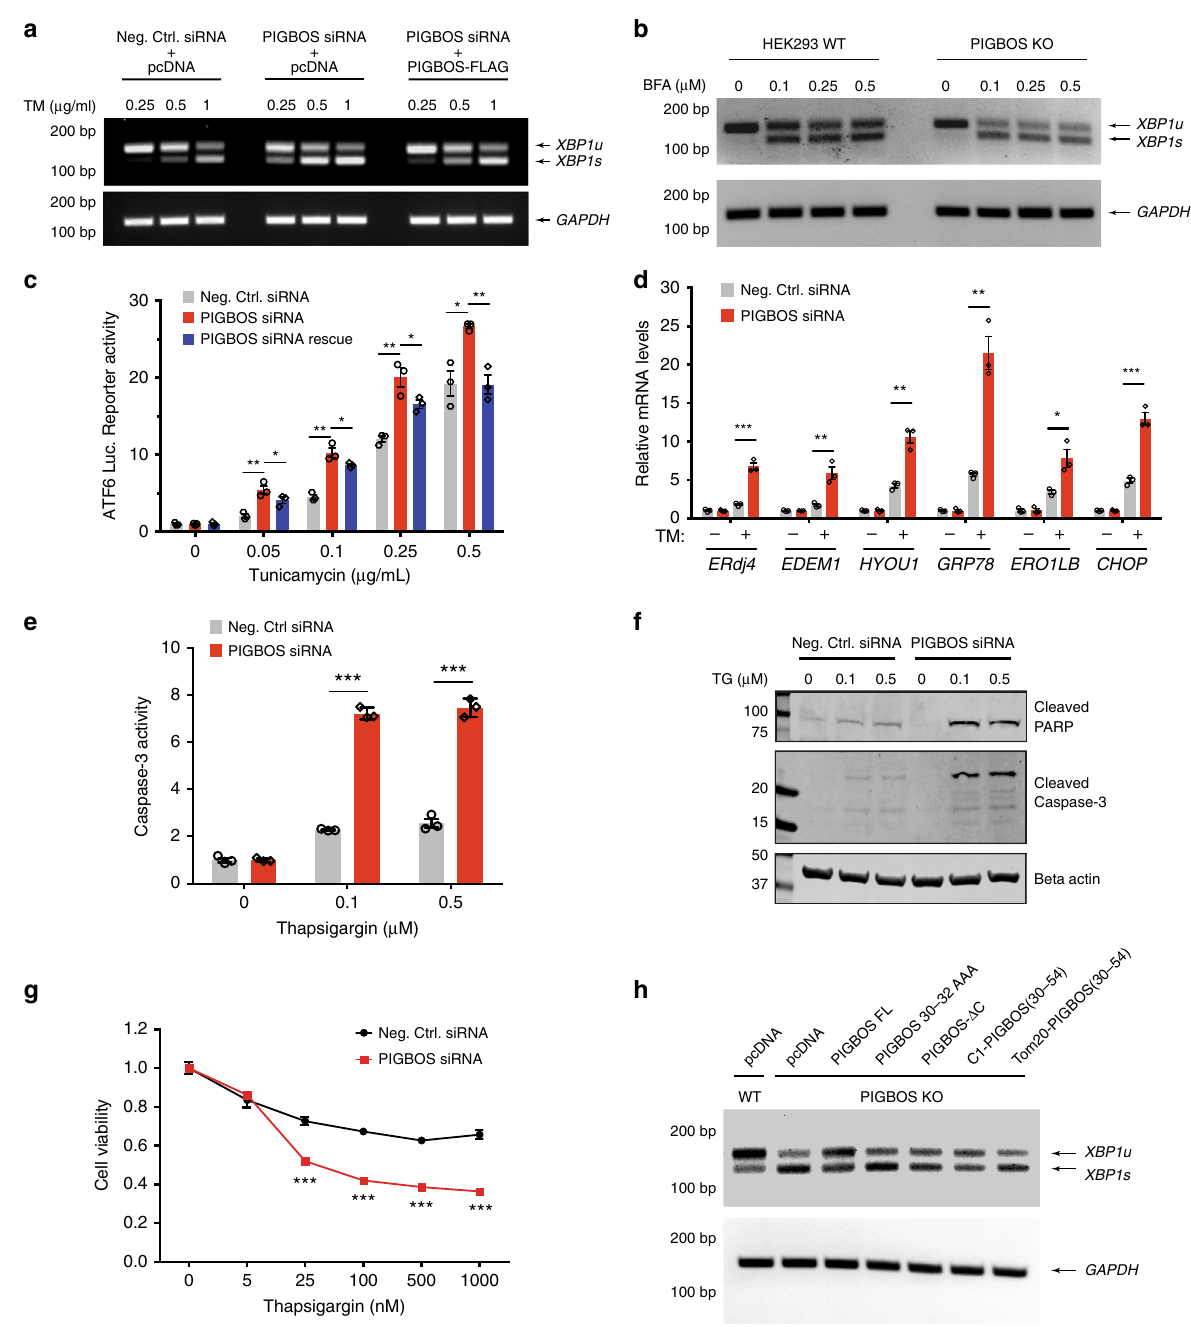
Fig. 6 PIGBOS regulates the amplitude of UPR, and apoptosis. a PIGBOS-KD and control HEK293 cells were treated with indicated concentrations of tunicamycin (TM) followed by RT-PCR analysis of XBP-1 splicing (unspliced XBP1 (XBP1u) and spliced XBP1 (XBP1s)). GAPDH was used as a loading control. A stronger UPR correlate with higher XBP1s/XBP1u ratio in PIGBOS-KD cells, which could be rescued by expression of a siRNA-resistant PIGBOS- FLAG. b XBP-1 mRNA splicing was measured in PIGBOS-KO and control HEK293 cells treated with indicated doses of brefeldin A (BFA) for 3 h. c ATF6- dependent luciferase reporter measures the activation of another branch of the UPR pathway. PIGBOS-KD led to increased luciferase activity indicative of a greater UPR, and the expression of the siRNA-resistant PIGBOS-FLAG reversed this effect. d RT-qPCR quantitation of a panel of UPR target genes in PIGBOS-KD and control HEK293 cells after an 8-hour treatment with vehicle or 1 μ g/ml of TM. e Caspase-3 activity in mock and PIGBOS-KD U2OS cells treated with thapsigargin (TG) for 27 h. f Cleaved PARP and caspase-3 levels were measured by Western blot in PIGBOS-KD and control U2OS cells treated with TG for 27 h. g PIGBOS-KD and control U2OS cells were treated with indicated doses of TG for 48 h followed by cell viability measurements using MTT. h HEK293 PIGBOS-KO and WT cells were transfected with PIGBOS variants constructs as indicated. Forty-eight hours later, cells were incubated with 1 µ g/ml of tunicamycin for 3 h. XBP1 splicing activity was measured by RT-PCR. Error bars, s.e.m. The p -values were calculated using two tailed unpaired t -test. * p < 0.05, ** p < 0.01, *** p < 0.001, n = 3 experiments. Source data for Fig. 6c – e and 6g are provided as a Source Data fi